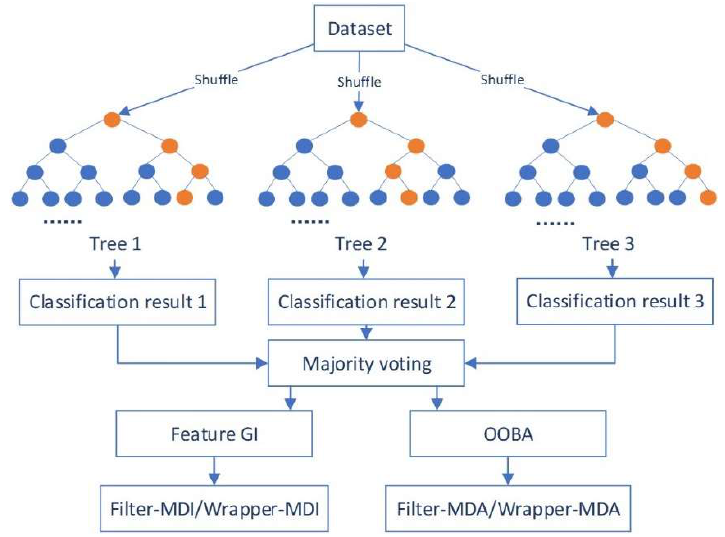
Figure 3. RF-based feature selection frame; for the FE, the classification results were not used.